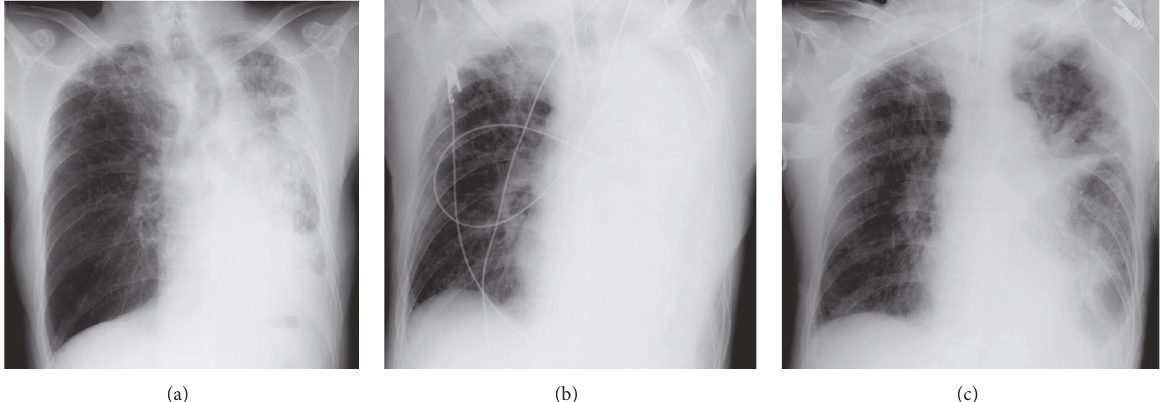
Figure 2: (a) Chest X-ray 3 days after admission revealed the progression of atelectasis in the left lung. (b) Chest X-ray on the day of intubation revealed complete atelectasis of the left lung. (c) Chest X-ray a day after the second electrocautery procedure showed marked improvement of the atelectasis of the left